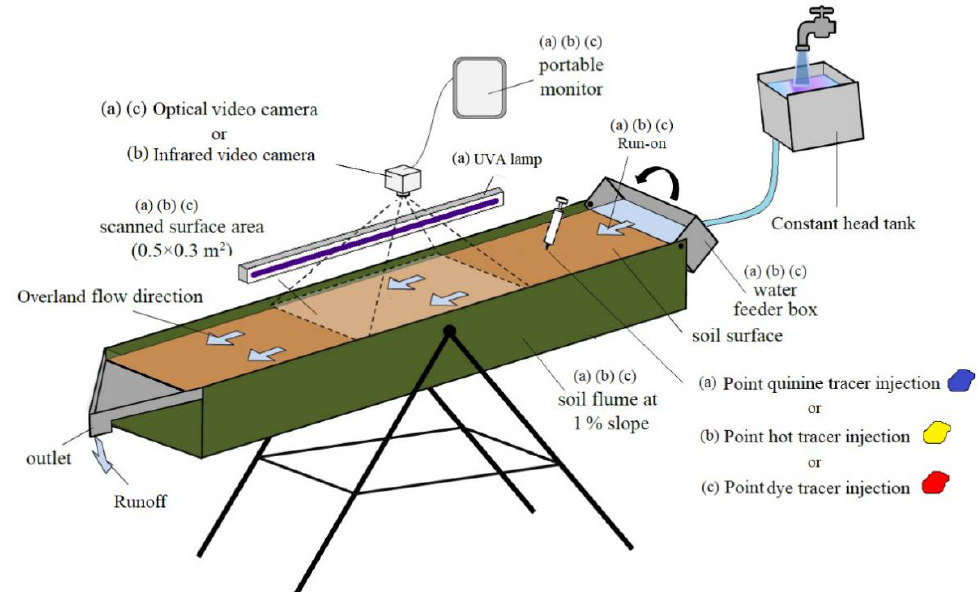
Figure 1. Schematic representation of the laboratory setup for: ( a ) Quinine tracer; ( b ) Thermal tracer; and ( c ) Dye tracer measurements.